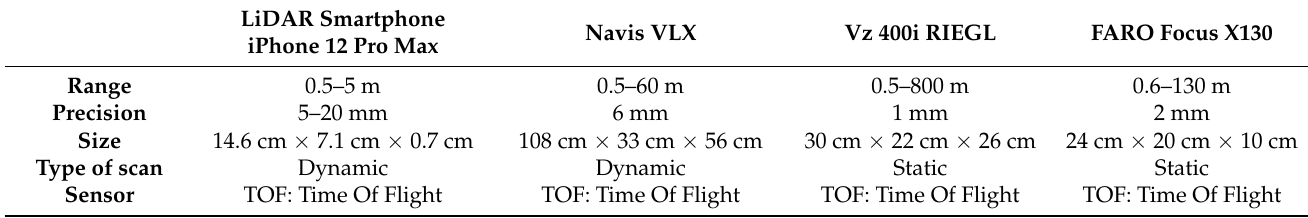
Figure 7. Different targets in the indoor environment. Table 2. Specifications for the LiDAR smartphone, the Navis VLX, the Vz 400i, and the FARO Focus X130.